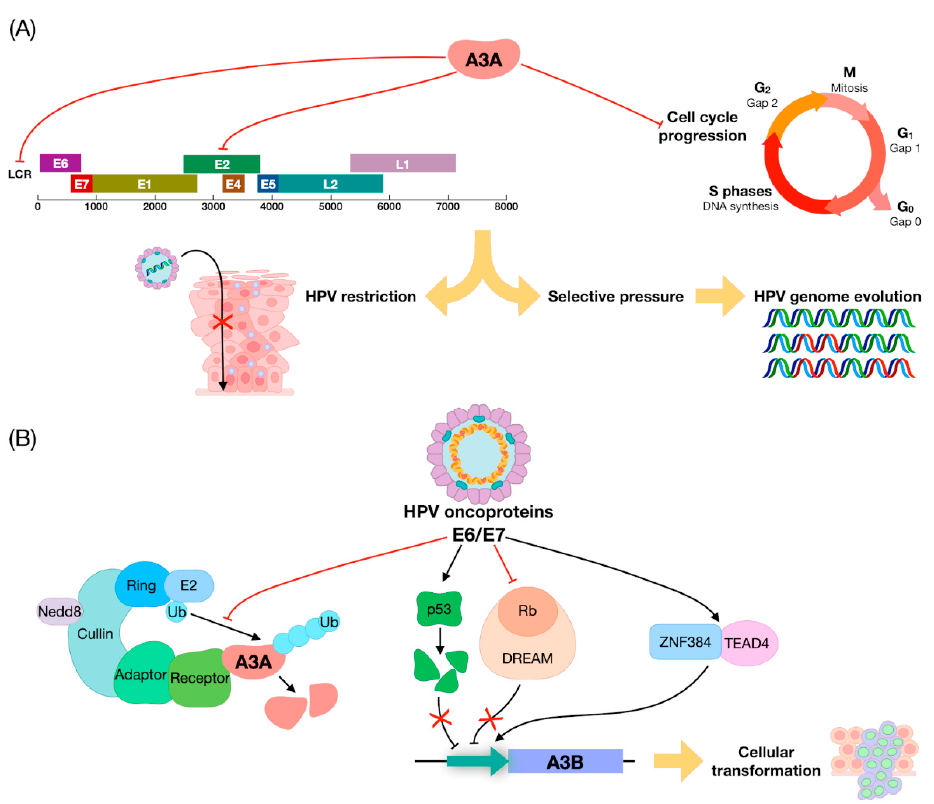
Figure 2. Summary of APOBEC3/HPV interplay. ( A ) Negative regulation exerted by A3A on human papillomavirus (HPV) gene expression and HPV-driven cell-cycle progression, leading to HPV restriction and genome evolution. ( B ) A3 modulation by HPV oncoproteins E6/E7: (i) cullin-RING-based E3 ubiquitin ligase-mediated polyubiquitination followed by A3A degradation; (ii) A3B upregulation through removal of the inhibitory activity exerted by p53 and Rb or through a direct effect of the zinc finger protein ZNF384 and TEAD4 on A3B